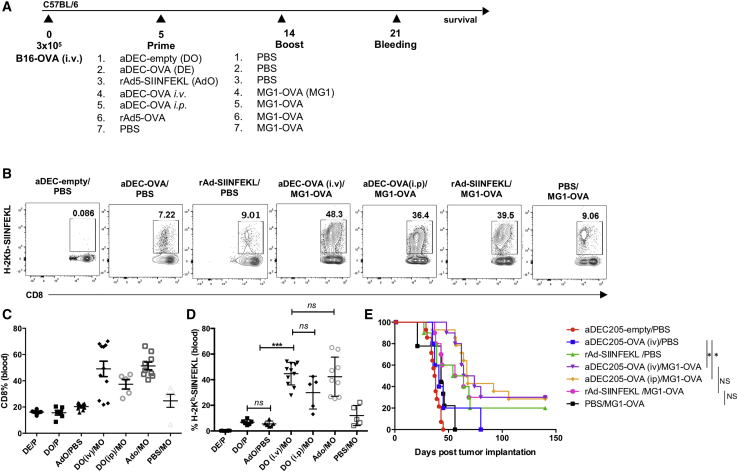
Therapeutic Efficacy of an aDEC205/OVA Prime-Boost Vaccine(A) Schematic representation of immunization schedule. Briefly, C57BL/6 mice received 3 × 105 B16-OVA cells i.v. At day 5, mice were immunized i.v. or i.p. with 10 μg of aDEC205-OVA or aDEC205-empty + 50 μg poly(I:C) + 50 μg anti-CD40, 108 rAd5-SIINFEKL, or PBS. At day 14, mice were immunized with a boosting dose of either PBS or 108 MG1-OVA. (B–D) At day 21 saphenous (saph) bleeds were performed to assess the percentage, by flow cytometry (B), of bulk-circulating CD8+ T cells (C) and SIINFEKL-specific CD8+ T cells (D), the latter determined by H2-Kb-SIINFEKL pentamer staining. p value was considered nonsignificant when >0.05; ∗∗∗p < 0.001 (one-way ANOVA). (E) Mice were monitored for survival 140 days post-B16-OVA implantation. Data from three independent survival experiments are pooled. p value was considered nonsignificant when >0.05; ∗p < 0.05 (log-rank Mantel-Cox).